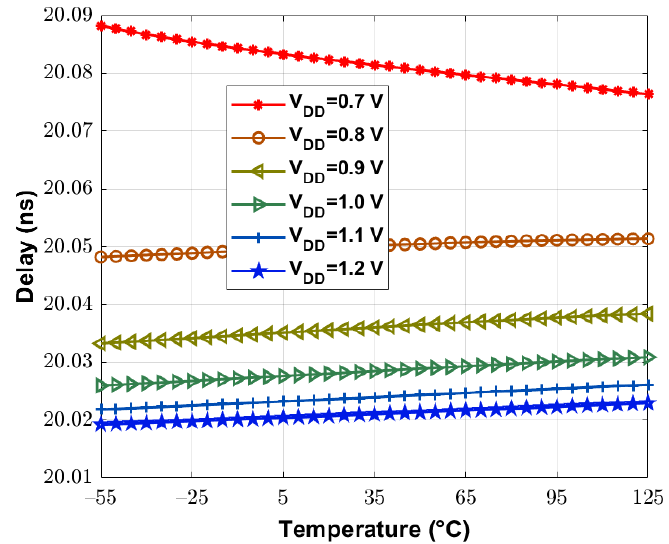
Figure 5. Simulated thermal and supply dependencies of the propagation delay, which is the sum of the rising and the falling delay, within the temperature range of − 55 and 125 °C, versus the supply voltage levels between 0.7 V and 1.2 V, for TT corner, in cadence environment using a 55 nm CMOS technology.